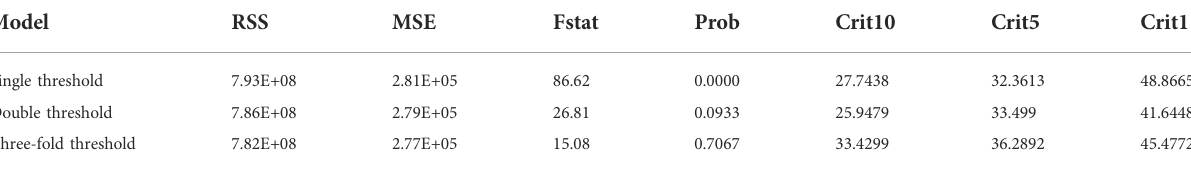
TABLE 5 Test results of the number of thresholds.